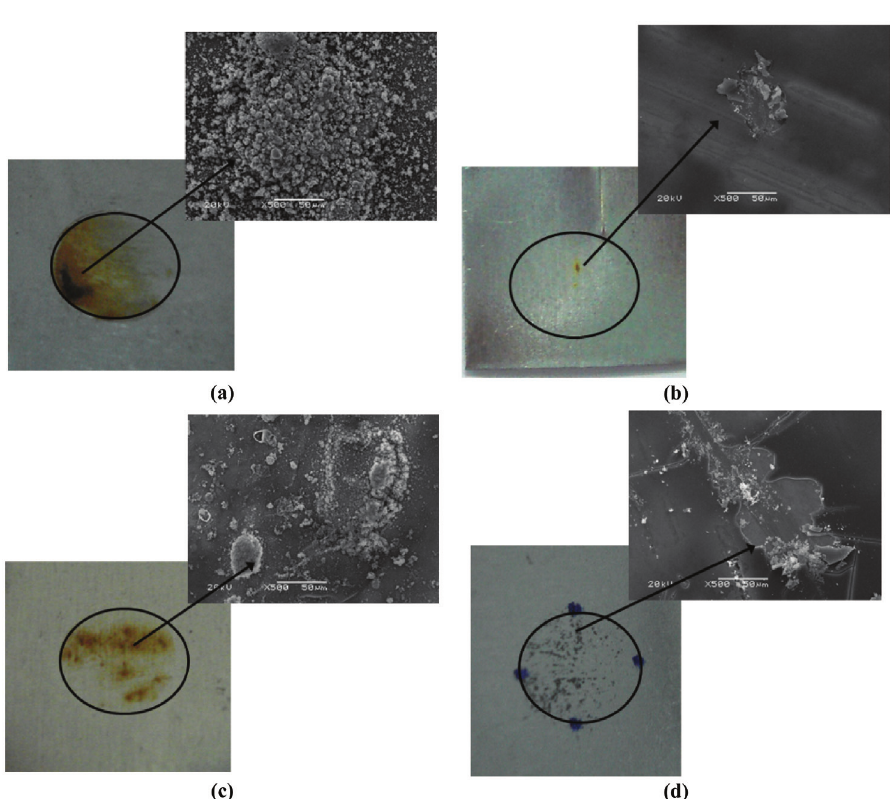
Figure 10. Images obtained after 96 hours of EIS in a 0.05 M NaCl solution: (a) tin plate, (b) acetic acid, (c) hydrochloric and (d) nitric